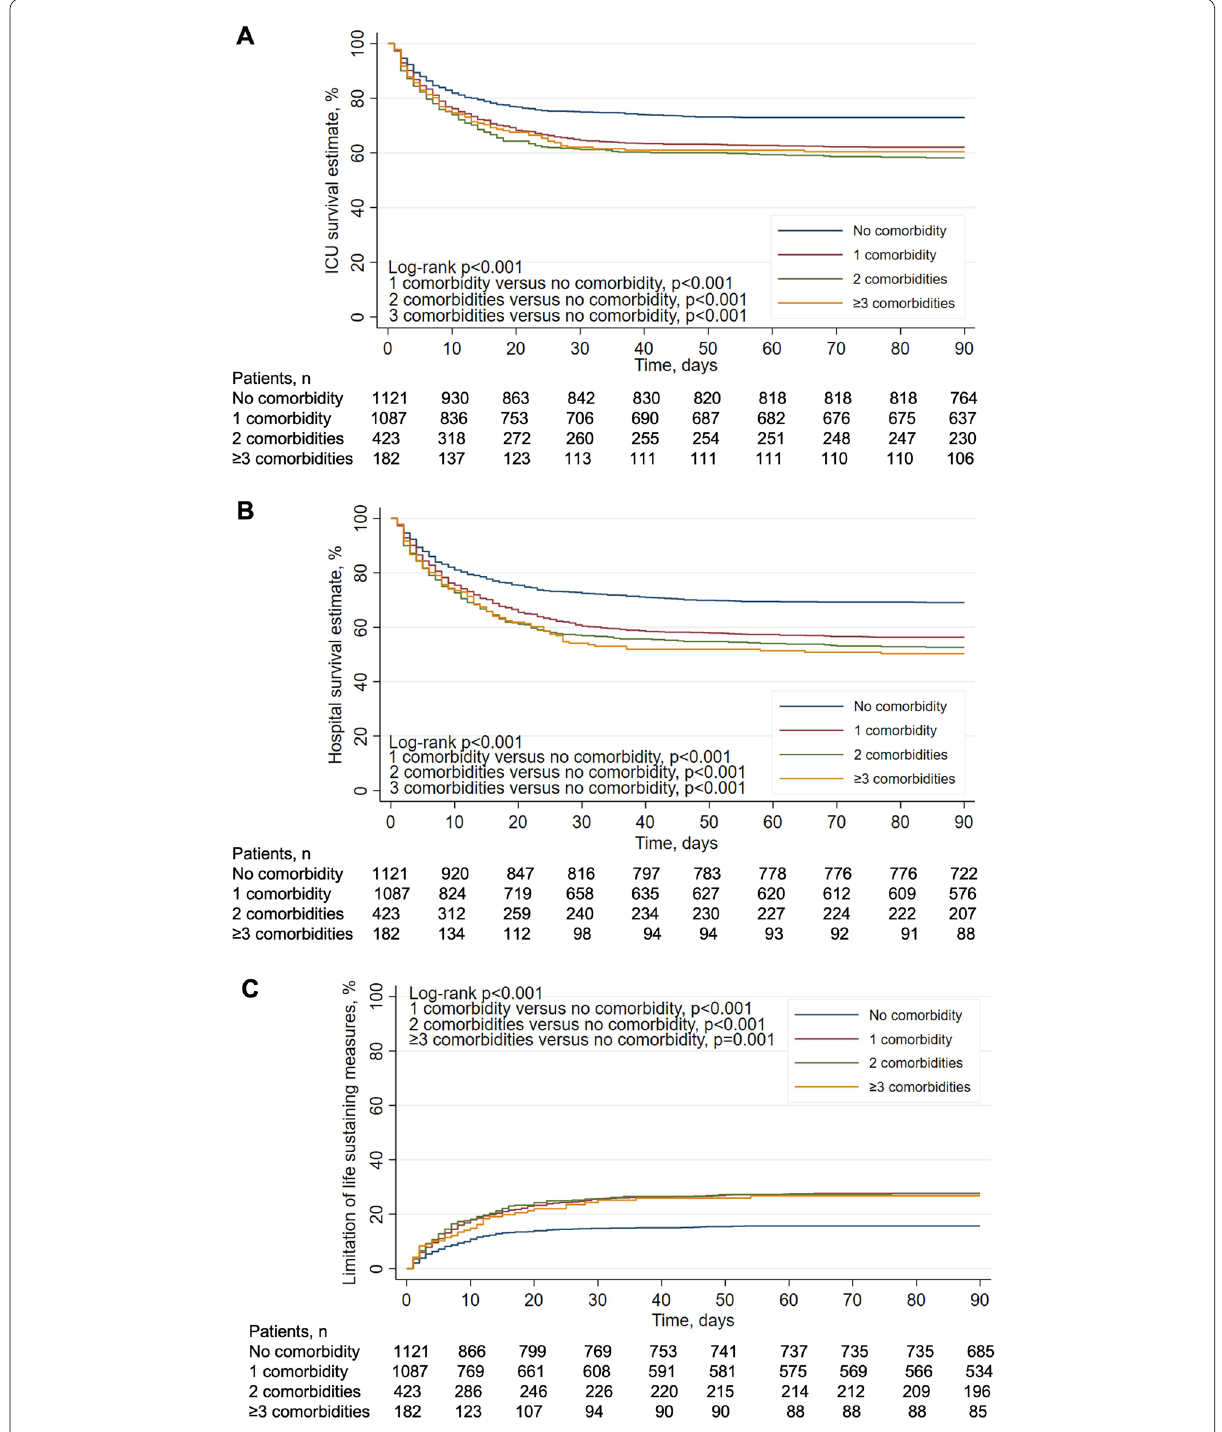
Fig. 3 Unadjusted probability of ICU ( A ) and hospital survival ( B ) and limitation of life-sustaining measures ( C ) at 90-day follow-up by increasing number of comorbidities. We used the log-rank test to assess the differences between